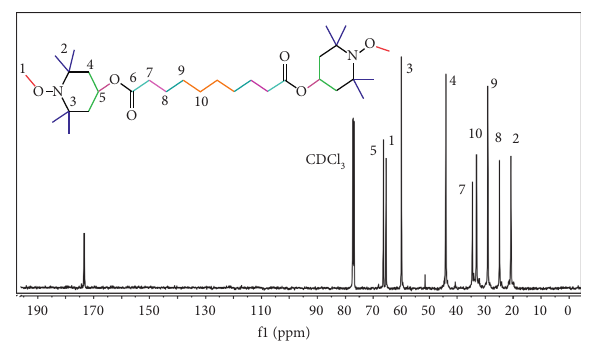
Figure 3: 13 C NMR of